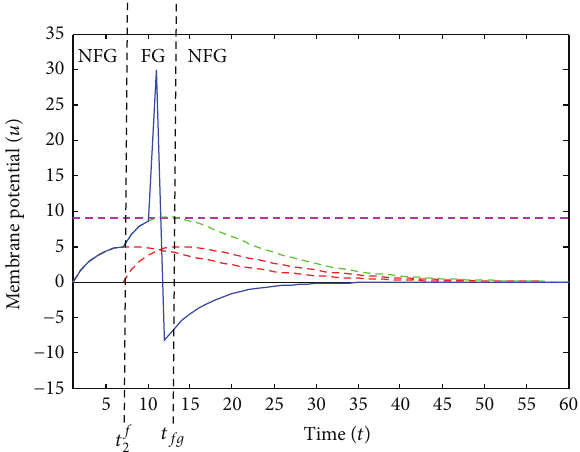
Figure 3: Illustration on firing region and nonfiring region of a CD neuron receiving 2 presynaptic spikes at 𝑡